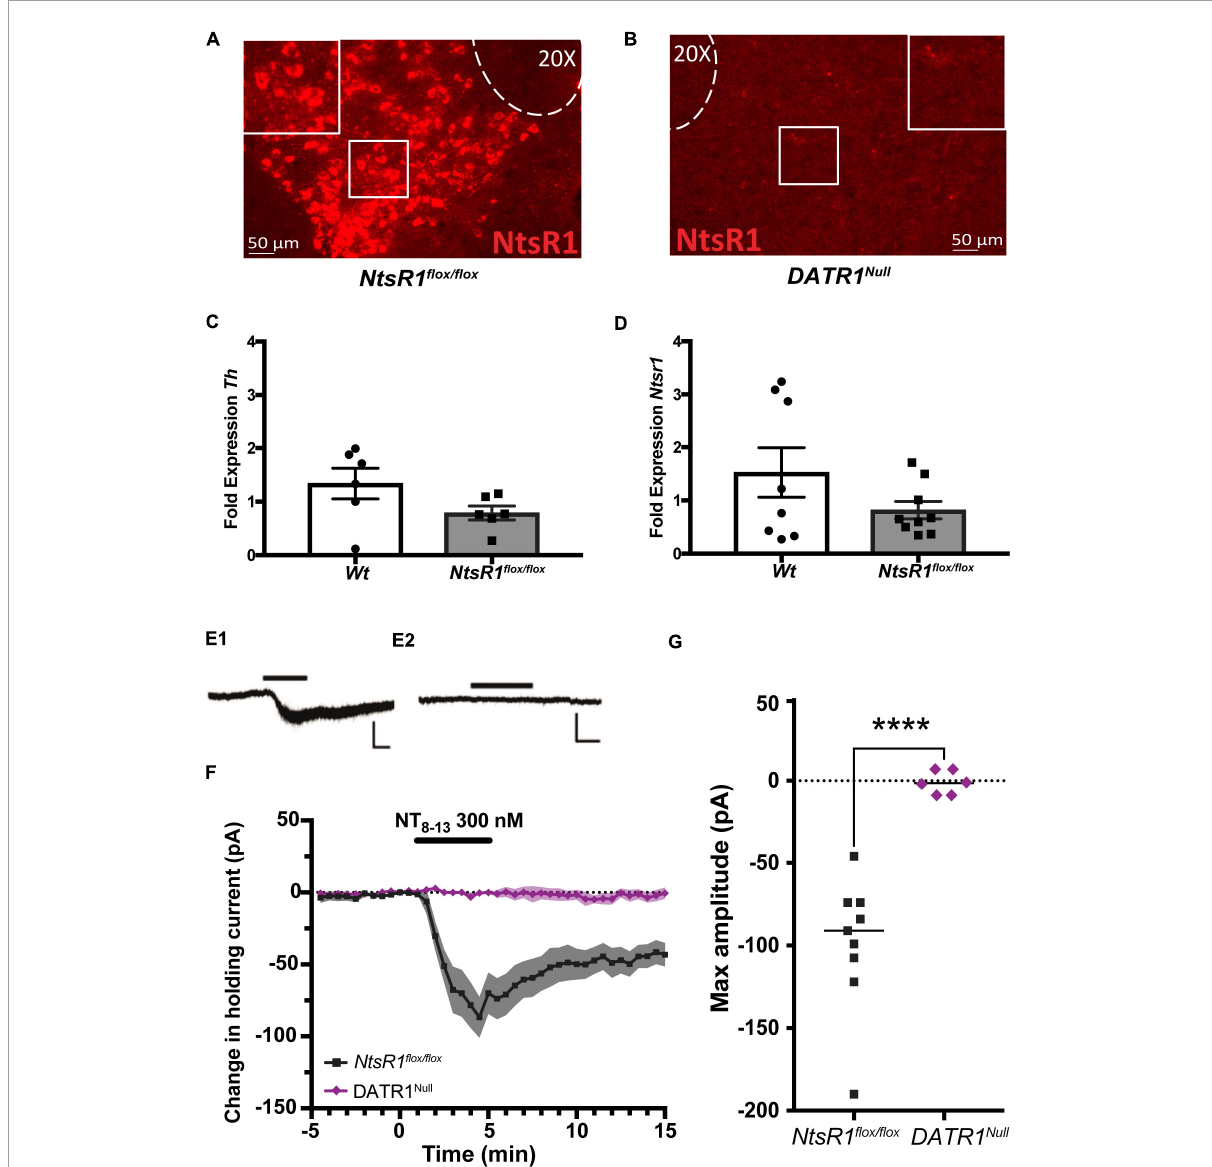
FIGURE1 Characterization of NtsR1 flox / flox mice and developmental deletion. (A,B) RNAScope analysis of Ntsr1 mRNA (red) confirms (A) intact Ntsr1 expression in the VTA of NtsR1 flox / flox mice but (B) absence of Ntsr1 in DATR1 Null mice, indicative of Cre-mediated NtsR1 deletion. (C,D) Analysis of VTA tissue from NtsR1 flox / flox and Wt littermates for fold difference in gene expression of (C) Tyrosine hydroxylase (Th) and (D) Ntsr1 . Graphs depict the fold change in gene of interest normalized to Gapdh ± SEM. (E1,2) Representative recording traces of VTA dopaminergic neurons from NtsR1 flox / flox (E1) and DATR1 Null (E2) during bath perfusion of the active peptide fragment NT 8 - 13 (5 min, 300 nM; horizontal black line). Scale bars: 100 pA, 2 min. (F) Summary data showing time course of change in holding current produced by NT 8 - 13 ( n = 9 NtsR1 flox / flox and 6 DATR1 Null cells). Graph depicts the mean change in holding current ± SEM. (G) Maximum change from baseline in holding current for individual cells. Graph depicts mean maximum amplitude. **** p < 0.0001 via unpaired Student’s t